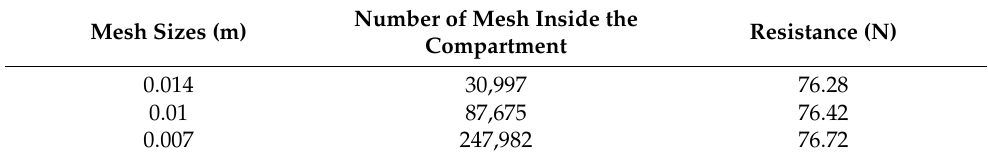
Figure 11. Mesh arrangement for the case of ship under symmetrical flooding. Table 8. Results of three different mesh sizes inside the compartment for damaged ship ( Fr = 0.30). Mesh Sizes (m)